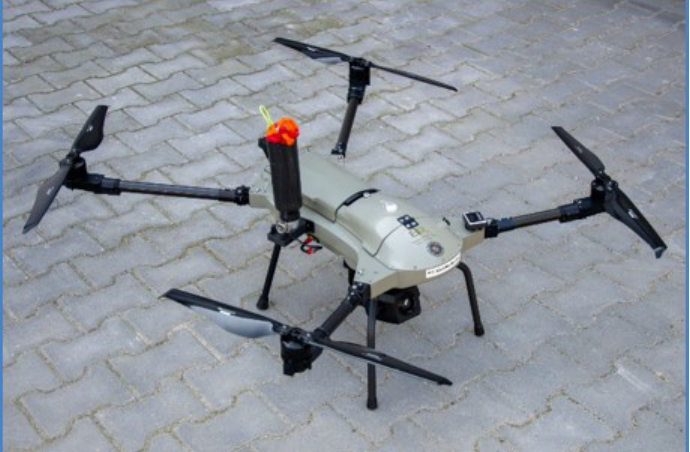
Figure 1. AtraxASF UAV used for drone modeling and simulation